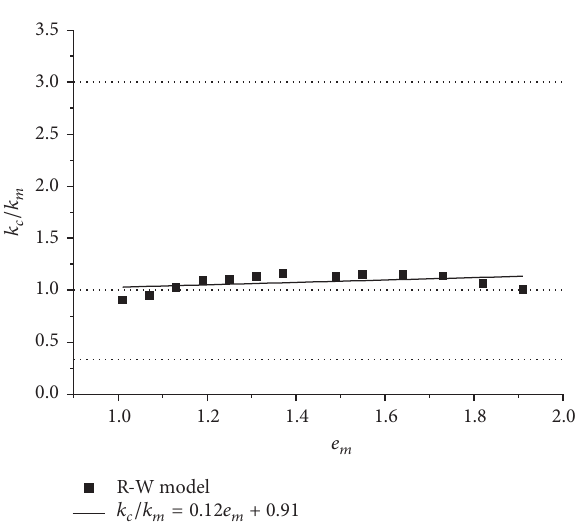
Figure 6: Comparison of the calculated and measured permeabili- ties of sea clay using the rec. model and the R-W model.